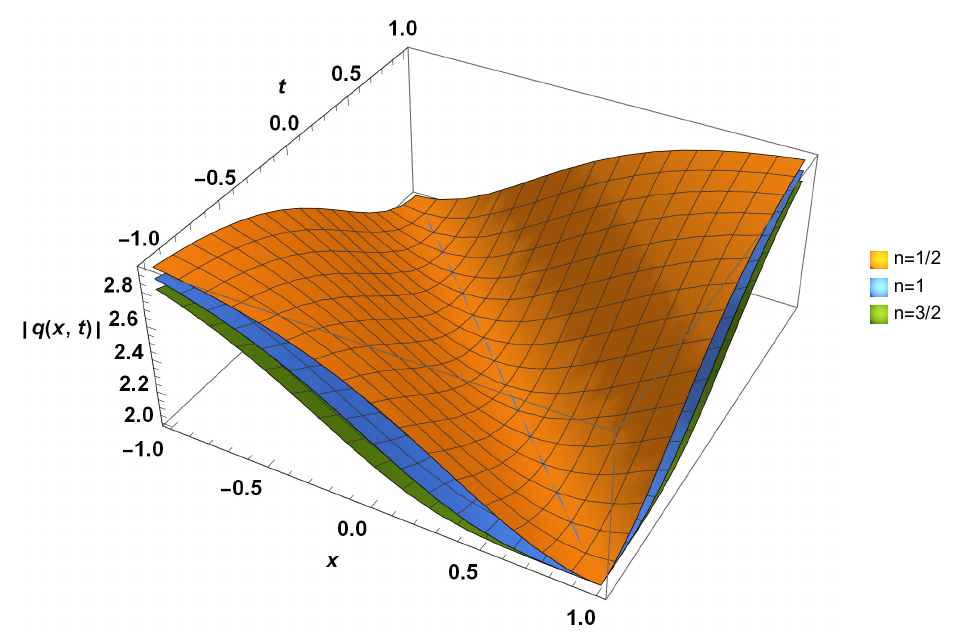
Figure 1. The amplitudes of a dark HD optical soliton (22), with α 0 = 1, b 6 = − 1, a 6 = 1, k = 1, a 2 = 1, a 3 = 1, κ = 1, a 4 = 1, and b 5 =